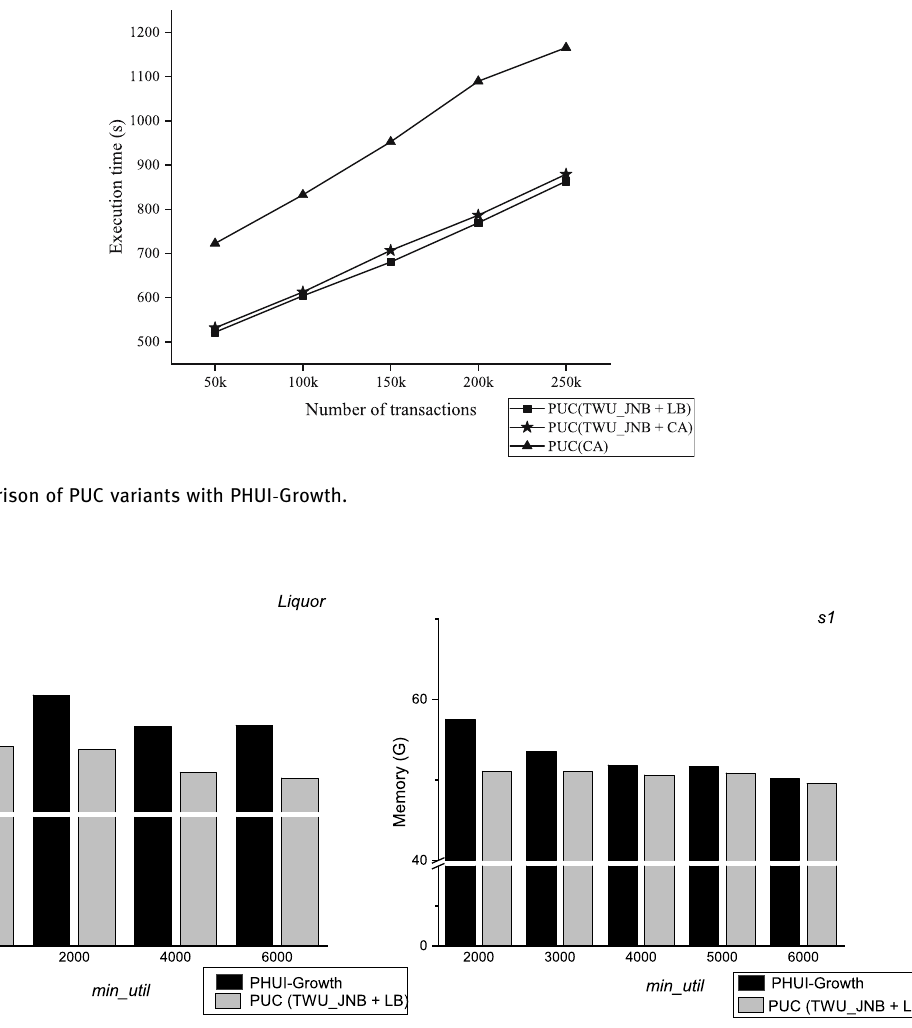
Figure 8: Comparison of cluster memory